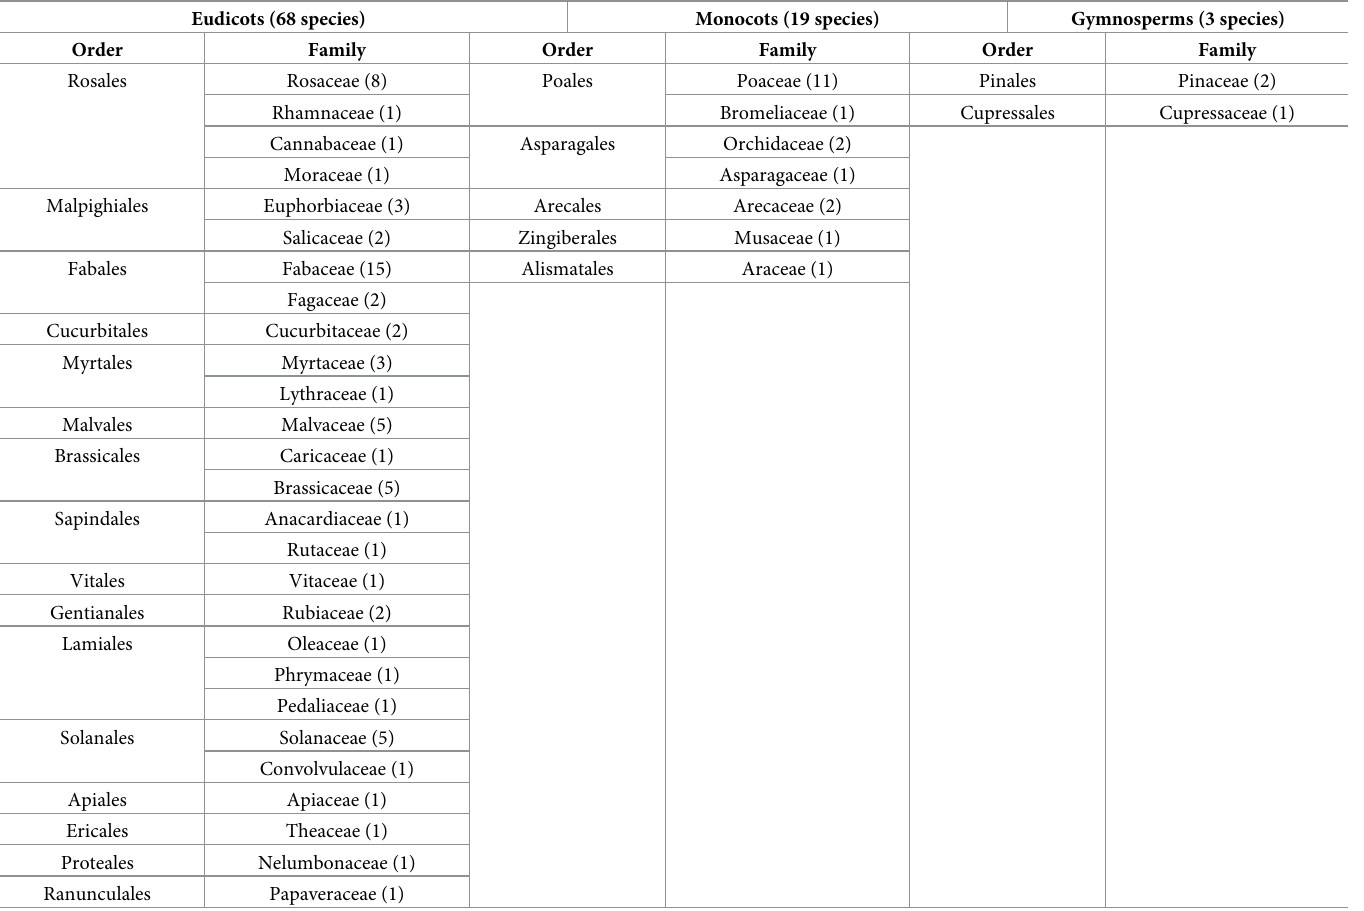
Table 2. Taxonomic presence of seed plant (Spermatophyte) KED